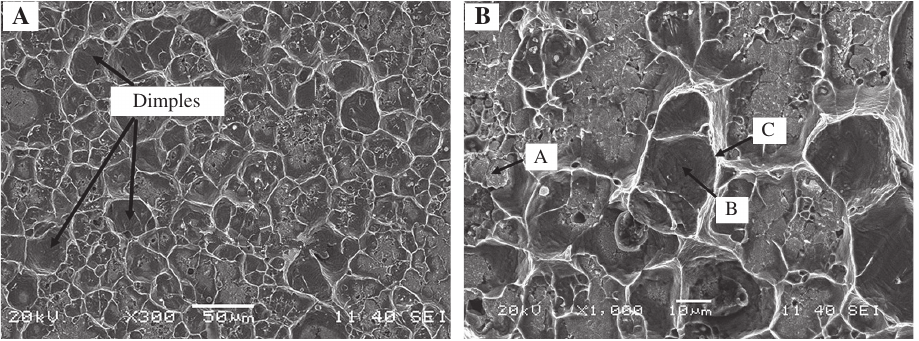
Figure 5 Micrograph of the fracture of the W-Cu/18-8 steel brazing layer. (A) Low multiples. (B) Higher